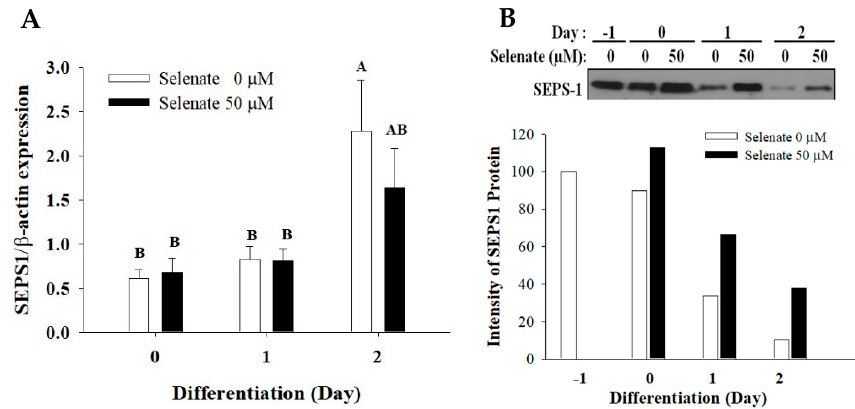
Figure 4. Selenate pretreatment induces a selenoprotein S (SEPS1) protein expression, but not a gene expression. After a 24 h pretreatment of one-day post-confluent 3T3-L1 preadipocytes with 50 µ M selenate, the cells were differentiated during Day 0–2 in the absence of selenate. During the early stage of differentiation, the SEPS1 gene ( A ) and protein ( B ) levels were determined by quantitative RT-PCR and immunoblot analysis, respectively. The data represent mean ± SEM. The experiment was conducted three times ( n = 3 or 9). Different characters indicate a significant difference at p < 0.05.